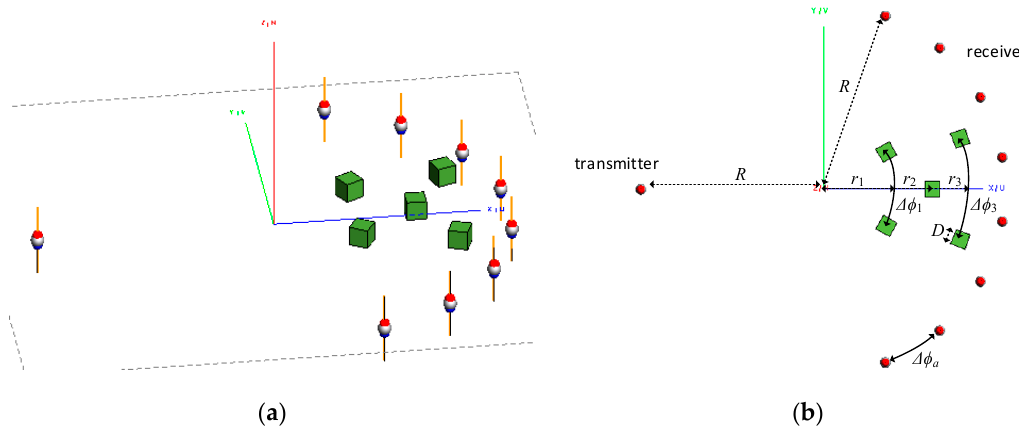
Figure 2. ( a ) Angled view of the FEKO simulation setup, and ( b ) Top-view of the setup consisting of one transmitter antenna and eight receiver antennas rotating together on a circle of radius R = 60 mm. The properties of the background medium are ε r = 22 and σ = 1.25 S/m. The properties of the objects are ε r = 55 and σ = 4 S/m.